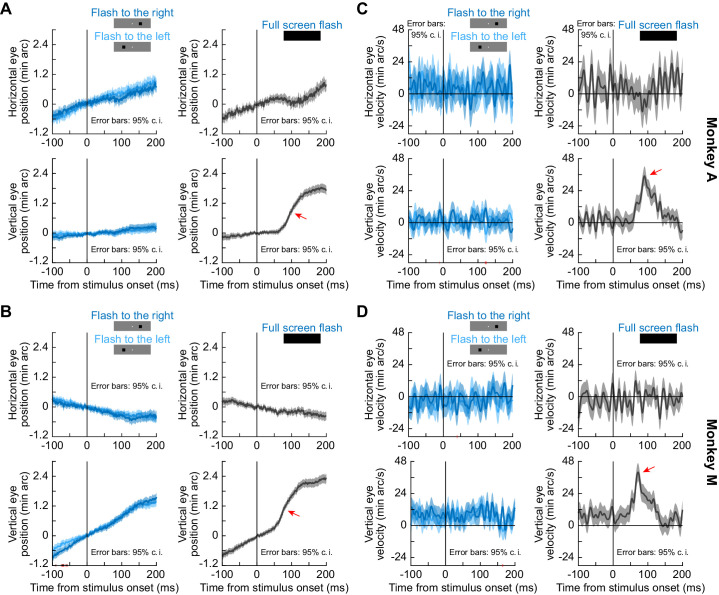
Small localized stimulus onsets had minimal effects on ocular position drifts when compared to larger flashes.(A, B) Horizontal (top row in each panel) and vertical (bottom row in each panel) eye position in each of two monkeys (A and M) under different conditions. The left column in each panel shows data when small localized flashes were presented in the black fixation flash paradigm (Methods; similar results were obtained with the white fixation flash paradigm). The right column shows the full-screen flash results of Figure 2 for comparison. All other conventions are like in Figure 2. As can be seen, the upward drift response with full-screen flashes was much bigger than any responses to small localized stimuli. Consistent with this, there was no single contiguous interval longer than 8 ms in duration for which horizontal or vertical eye position differed between whether a localized flash was presented to the right or to the left of fixation (pink intervals on the x-axis of the bottom left panel of B), denoting when the 95% confidence intervals did not overlap with each other between the two compared curves). (C, D) Eye velocity measurements for the same data as in (A), (B). There were no time intervals during which the right and left flash eye velocity curves differed from each other (that is, there were no pink intervals on x-axes denoting a lack of overlap between 95% confidence intervals). We also confirmed that in the interval of 50–140 ms after stimulus onset, peak vertical eye velocity was not different between rightward and leftward localized flashes (p=0.64, Z = 0.47 for monkey A and p=0.92, Z = −0.10 for monkey M; Wilcoxon rank sum test). A similar conclusion was also reached for peak horizontal eye velocity (p=0.5, Z = −0.68 for monkey A and p=0.52, Z = −0.65 for monkey M). Error bars in all panels denote 95% confidence intervals.